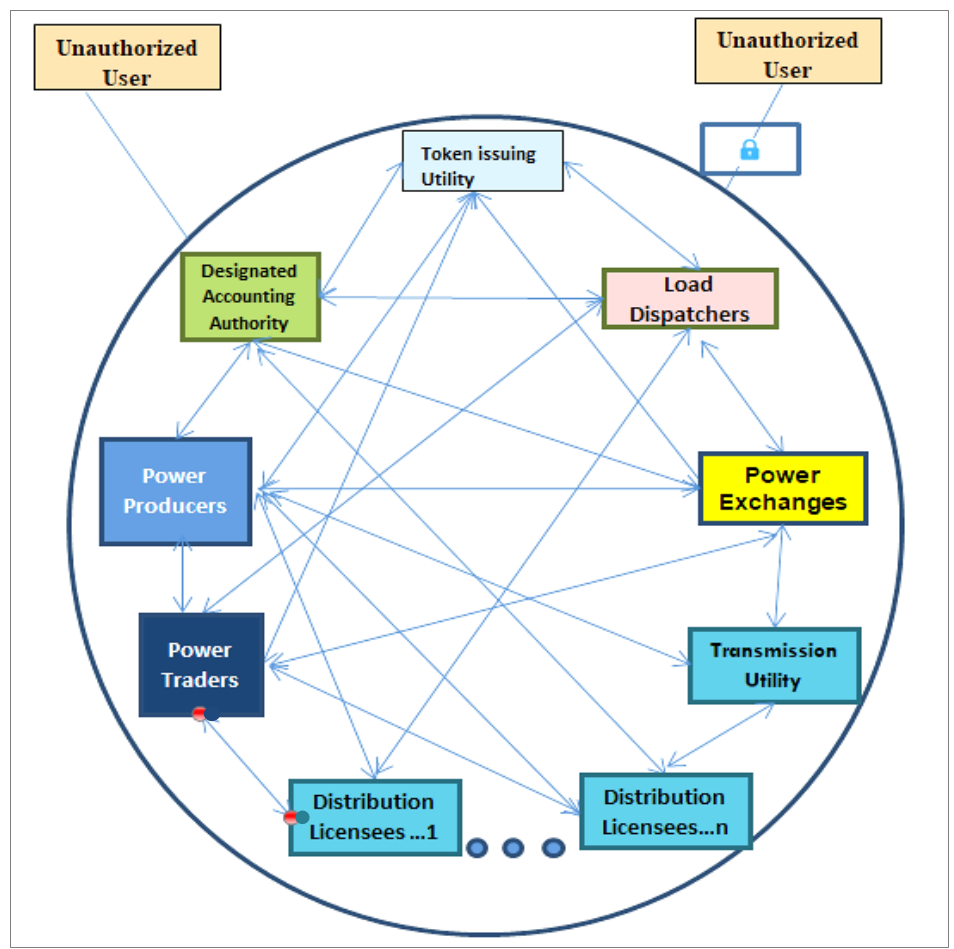
Figure 2. Distributed Network of Stakeholders participating in Energy Banking